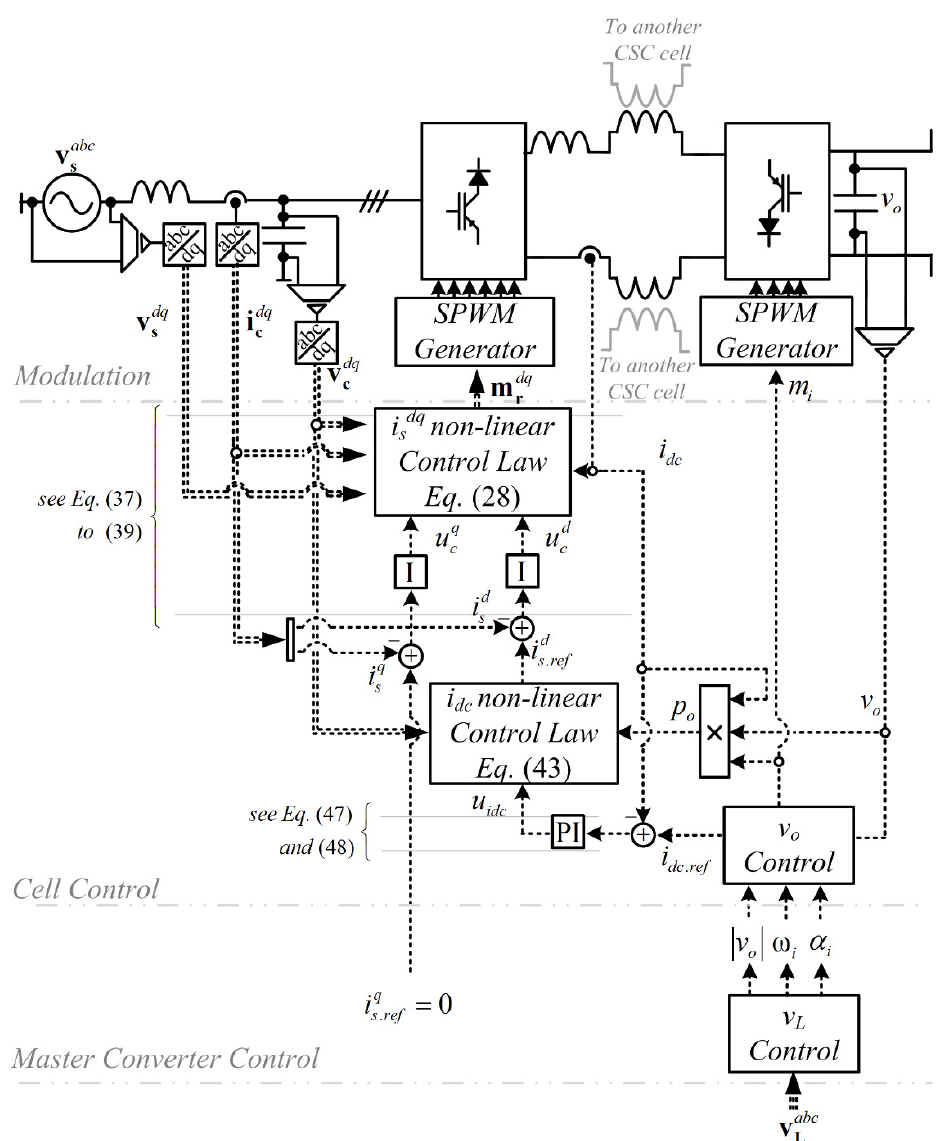
Figure 3. Control scheme for each cell.